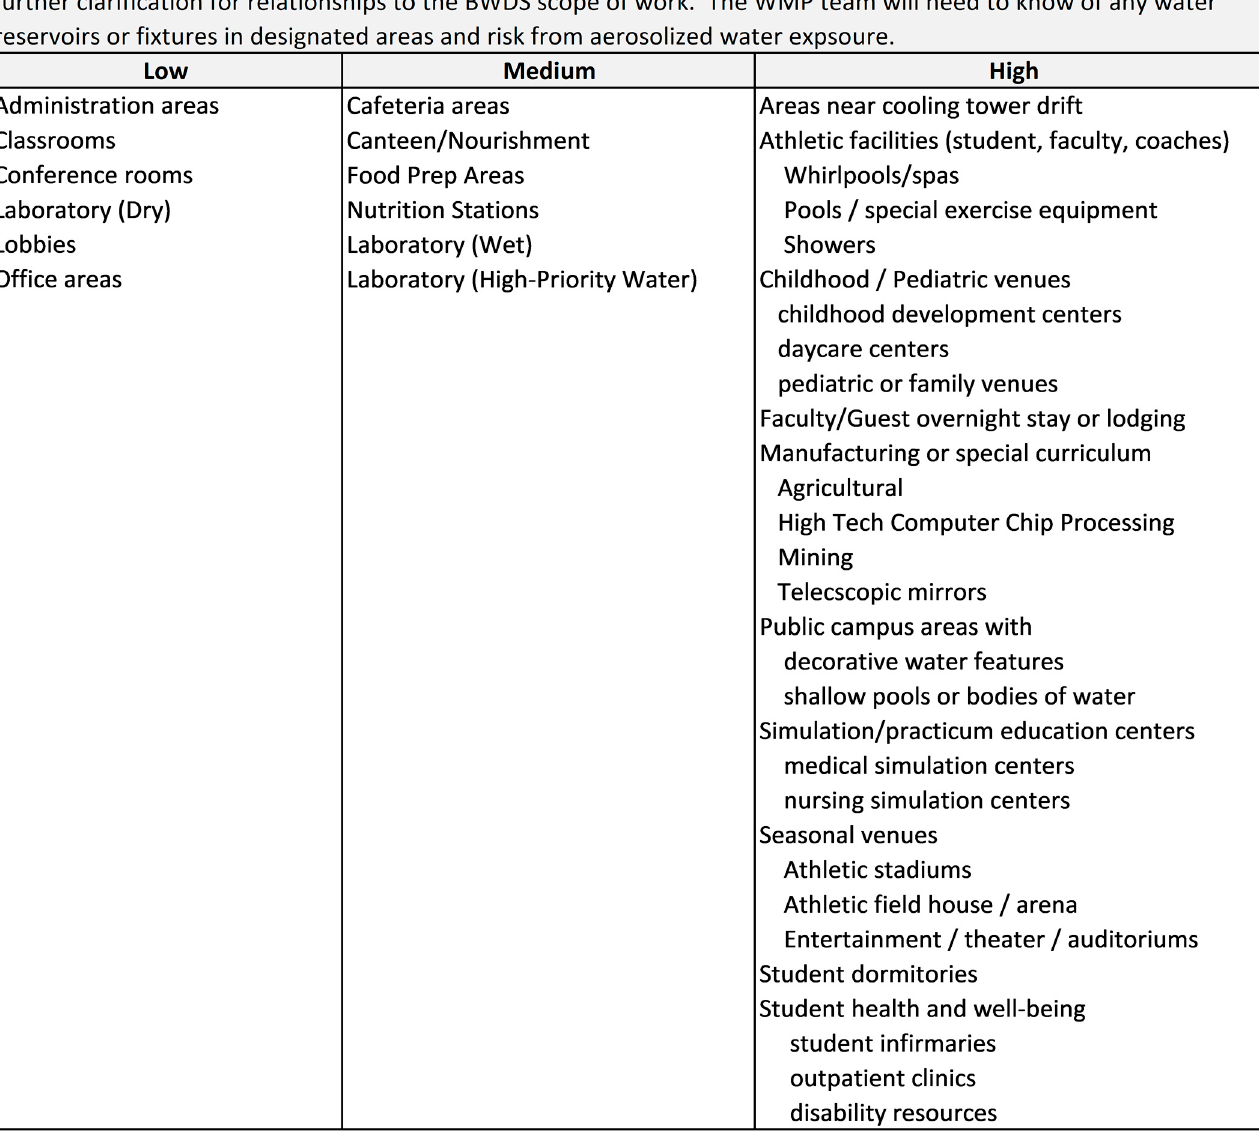
Figure 5. WQSRA building occupant risk groups. Adapted with permission from Ref. [50]. 2022, Scanlon et al. (CC BY 4.0).